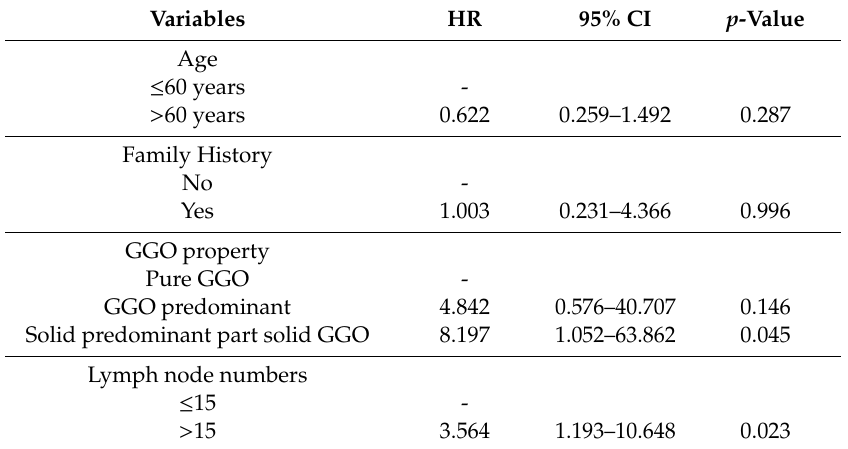
Table 3. Multiple Cox regression for the lobectomy patients with lymph node